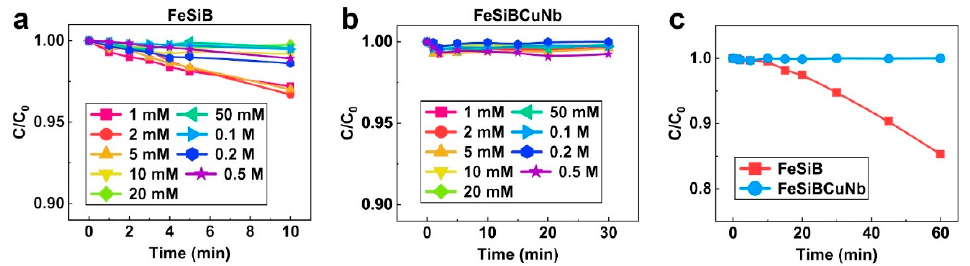
Figure 8. Effect of H 2 O 2 concentration from 1 mM to 0.5 M using ( a ) Fe 78 Si 9 B 13 (FeSiB) and ( b ) Fe 73.5 Si 13.5 B 9 Cu 1 Nb 3 (FeSiBCuNb) metallic glass ribbons under neutral conditions. ( c ) Comparison of MO degradation by Fe 78 Si 9 B 13 (FeSiB) and Fe 73.5 Si 13.5 B 9 Cu 1 Nb 3 (FeSiBCuNb) at 0.5 M H 2 O 2 and neutral condition (MO dye concentration: 20 ppm, catalyst dosage: 0.5 g / L, pH 6.2 ( ± 0.1),